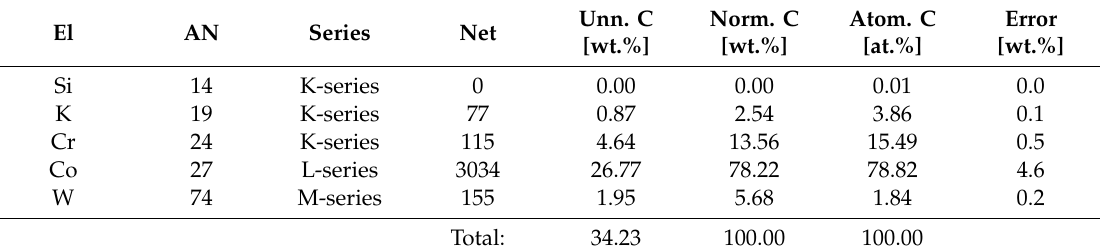
Table 6. The elemental contents of the EDS multi-point sampling area (used electrode).